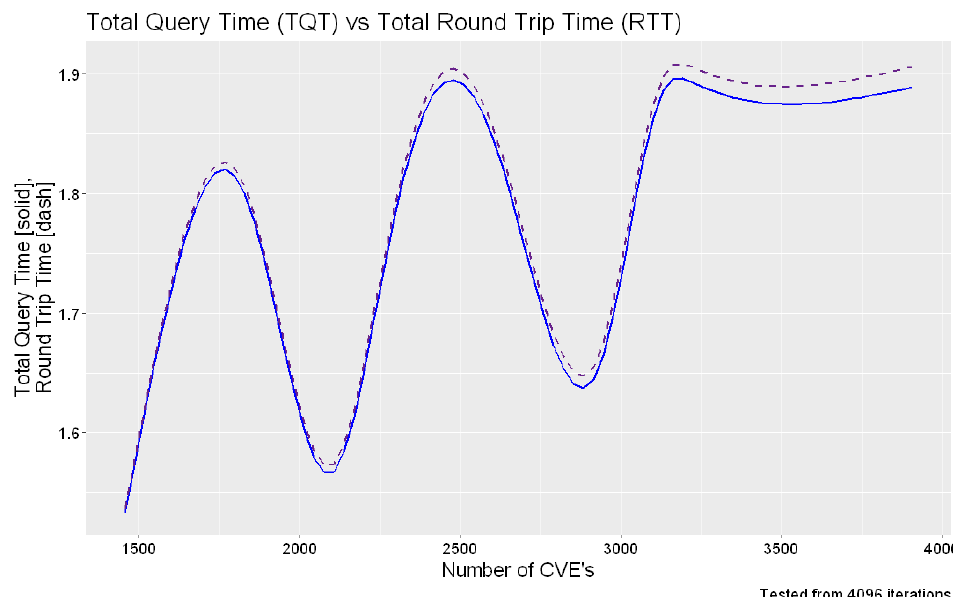
Figure 8. SQL Query time vs. Round Trip